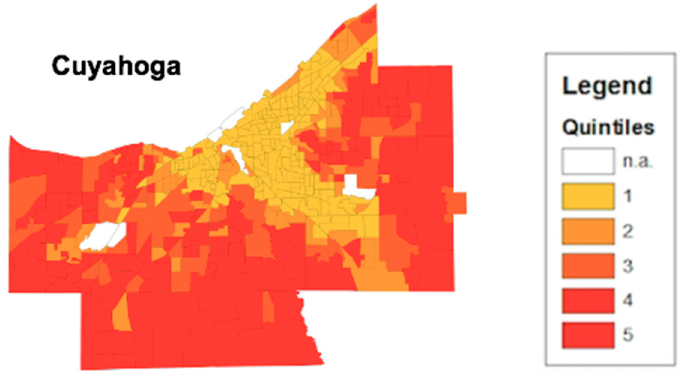
Figure 3. HOI Composite Score map from Cuyahoga County. The thematic map displays census tracts in Cuyahoga County in northeast Ohio. The census tracts are color coordinated based on what quintile their HOI composite score falls in. The lower HOI Composite scores fall in the first quintile while the higher HOI scores fall in the fifth quintile.